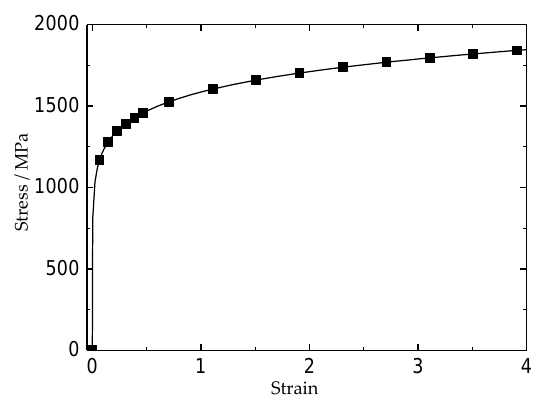
Figure 5. Strain-stress curve of Cr5VMo steel (calculated by JmatPro at 20 °C).